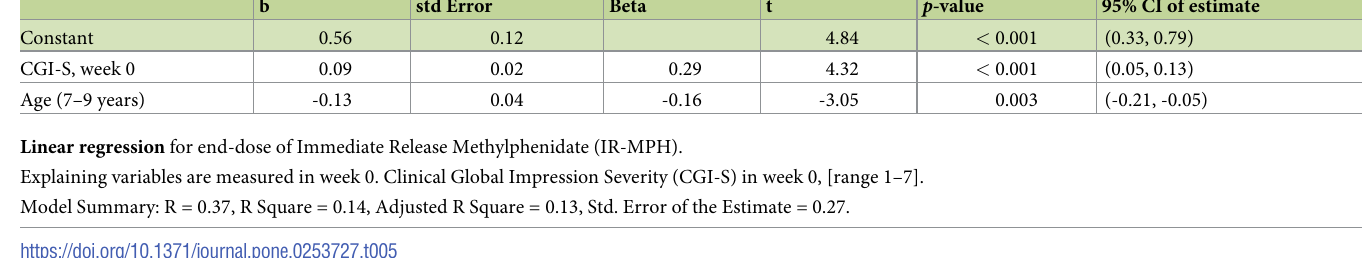
0–27. Only last model of cox regression with backward elimination are listed in the table. HR = Hazard ratio. Independent predictors: Sex, age, comorbidity ( � 2 comorbid diagnosis), and intelligence level ( inferioritas intellectuals , ICD10-R41.8) from the diagnostic conference and/or from the intelligence test (WISC) (IQ = 70–85) depending on data access).